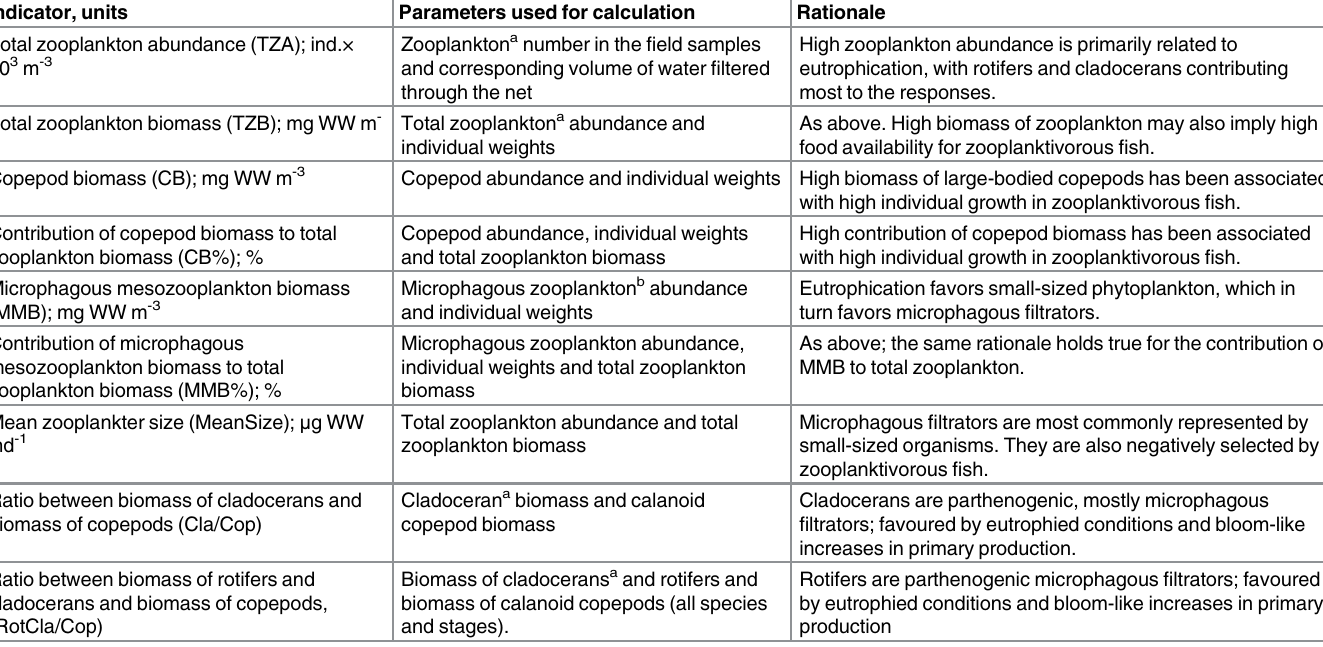
Table 2. Indicator description, calculation principles, and rationale. Only species/groups that are included consistently in the zooplankton analysis were used for